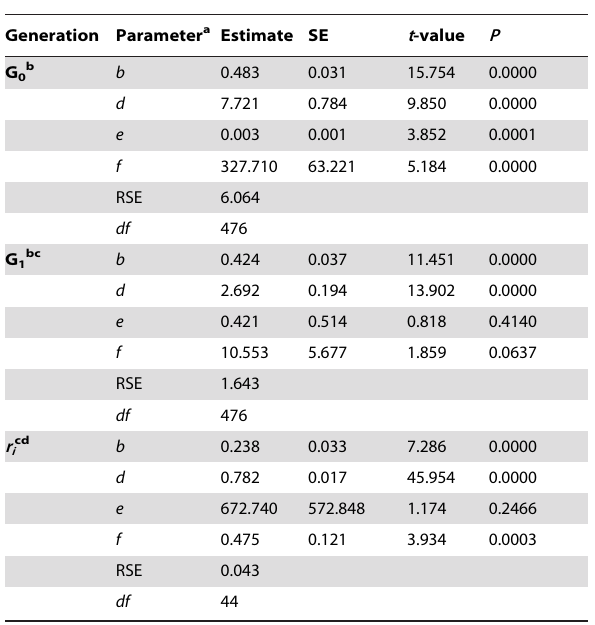
Generation Parameter a Estimate